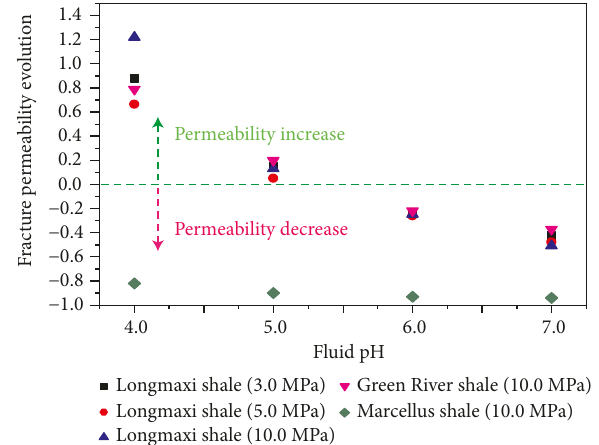
Figure 7: The summary of fracture permeability evolution